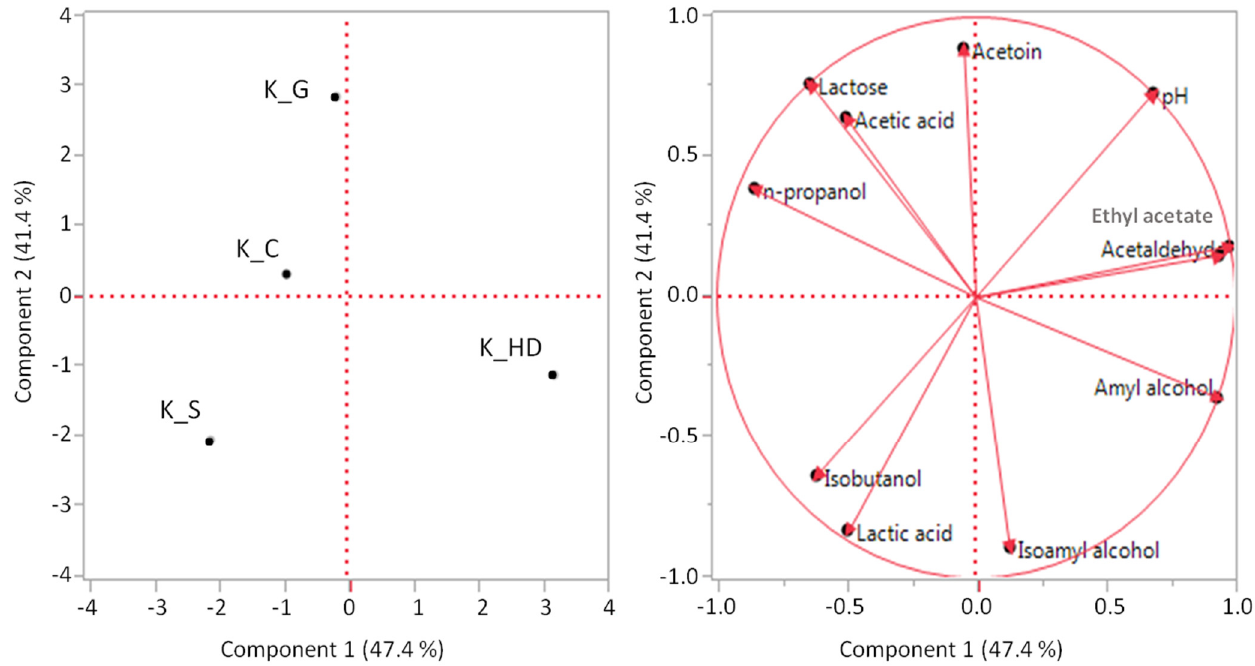
Figure 4. Principal component analysis based on the data regarding the main analytical characters and by-products of fermentation of the kefir obtained by the yeast consortium using different milks: whole cow’s milk (K_C), lactose-free cow’s milk (K_HD), goat’s milk (K_G), and sheep’s milk (K_S).